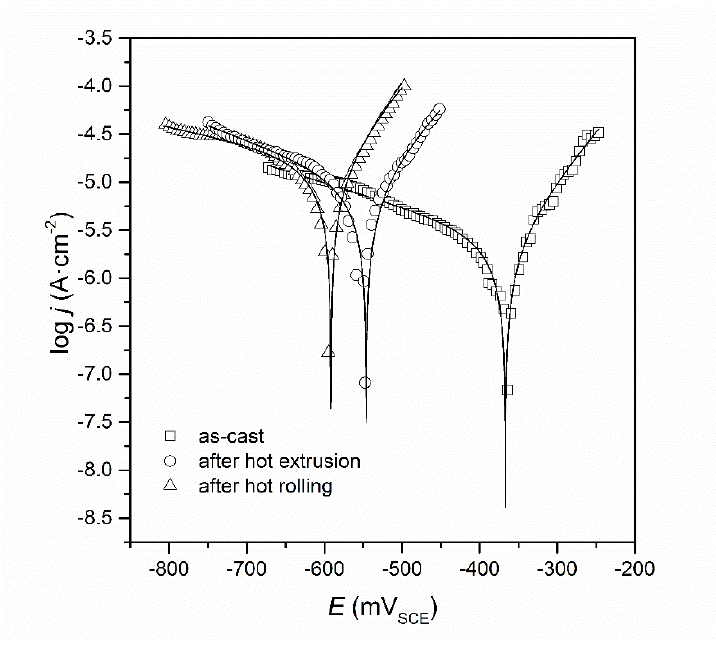
Figure 10. Dependences of log j = f( E ) for the FeAl alloys.